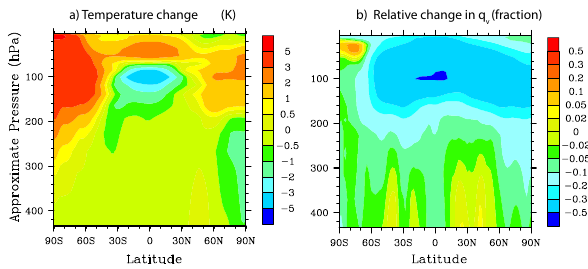
Figure 11 Fig. 11. Annual average zonal mean (a) temperature change (unit: K) and (b) relative change in specific humidity (unit: fraction) from the HMHT 0.01IN case to the HMHT 0.1IN